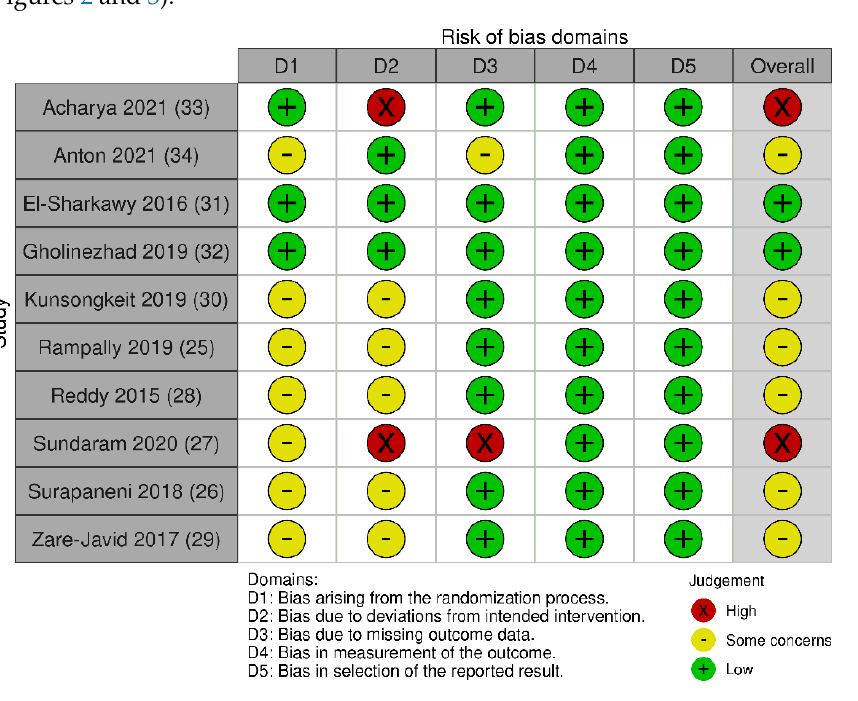
Figure 2. Traffic light plot of risk of bias assessment of included studies for each RoB v2.0. tool domain, and overall risk of bias.